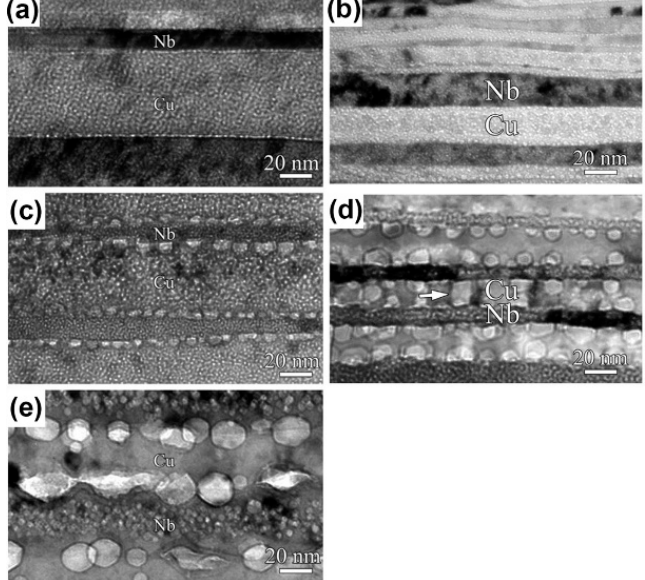
Figure 8. TEM images of accumulative roll bonding (ARB) Cu/Nb after He ion irradiation with different layer thickness, implantation dose and temperature. ( a ) 58 nm, 2 × 10 17 ions/cm 2 , room temperature (RT); ( b ) 16 nm, 2 × 10 17 ions/cm 2 , RT; ( c ) 58 nm, 6.5 × 10 17 ions/cm 2 , RT; ( d ) 16 nm, 2 × 10 17 ions/cm 2 , 450 °C; ( e ) 58 nm, 2 × 10 17 ions/cm 2 , 450 °C [22].